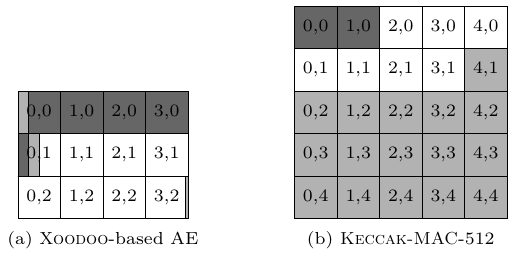
Figure 5: Key pack of Xoodoo in Ketje style and Keccak-MAC -512, where gray lanes are the key, light gray lanes denote constants and white lanes are the nonce or